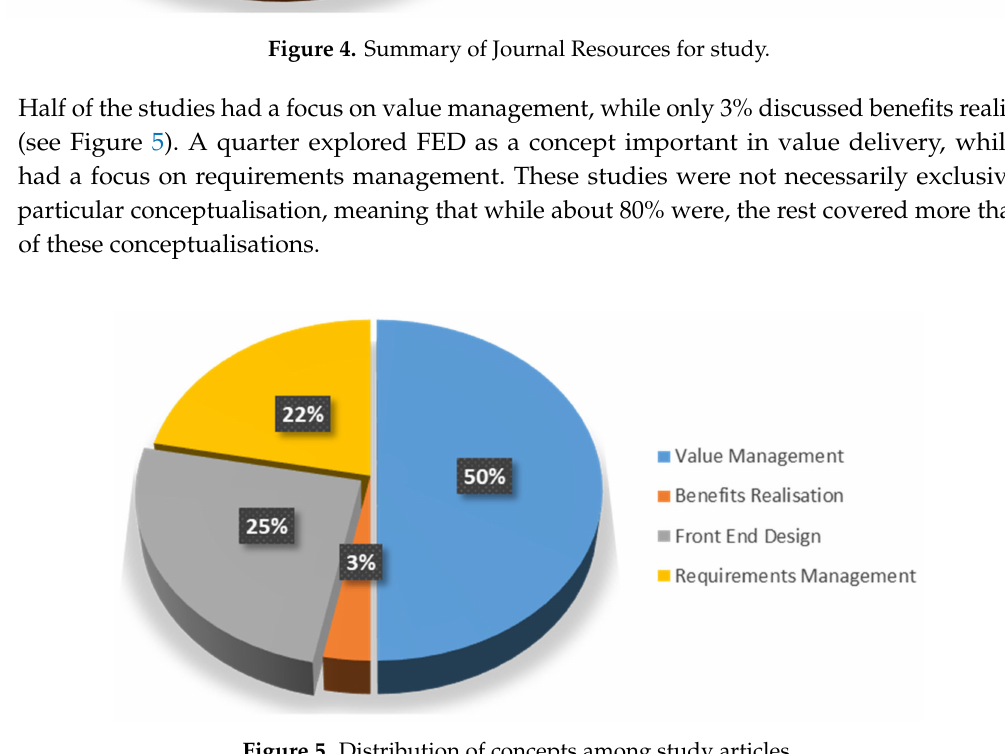
Figure 5. Distribution of concepts among study